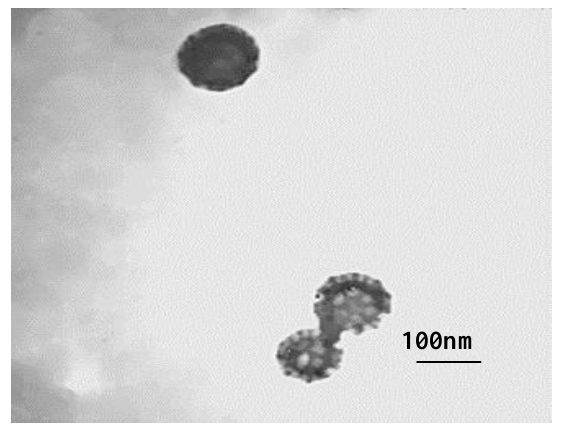
Fig.11: A typical TEM image showing a group of nano-sized carbon particles with prefect spherical